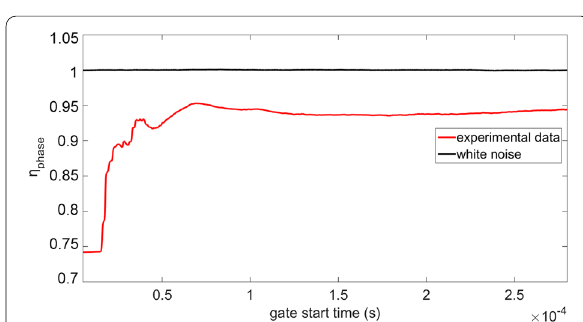
Figure 12 Diffuse field verification on white noise and experimental data using metric η